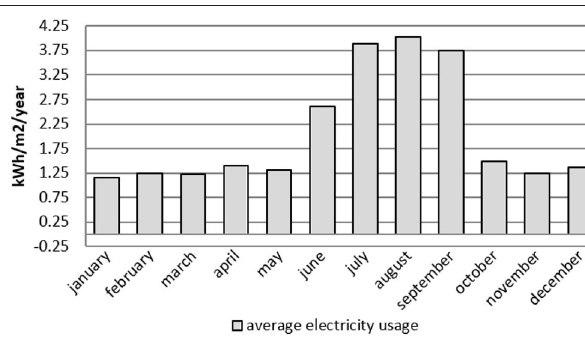
FIGURE 4 | The actual monthly average electricity consumption of the case study.